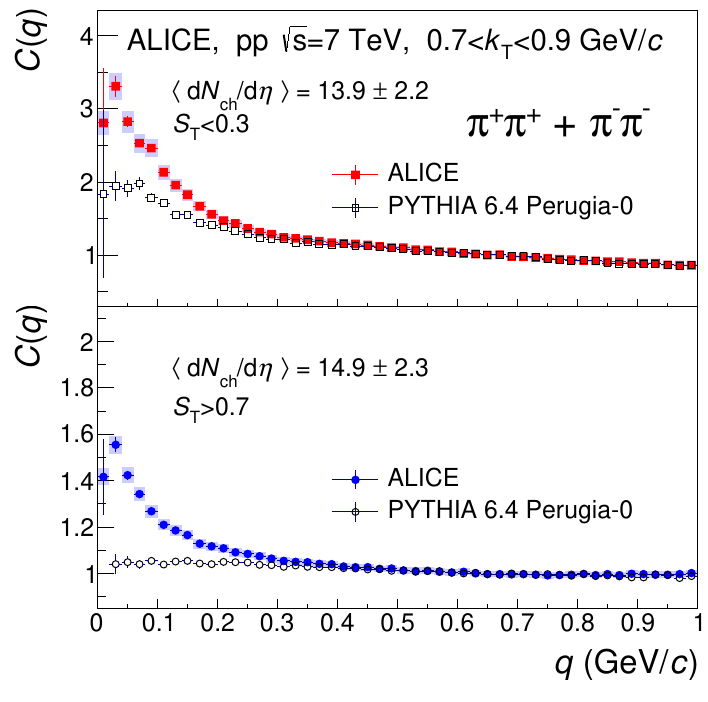
Figure 2 . Comparison of same-sign correlation functions for data and PYTHIA simulations for both sphericity intervals. The error bars represent statistical uncertainties and the shaded boxes are systematic uncertainties. Note that the vertical axes have di(cid:11)erent scales in the two